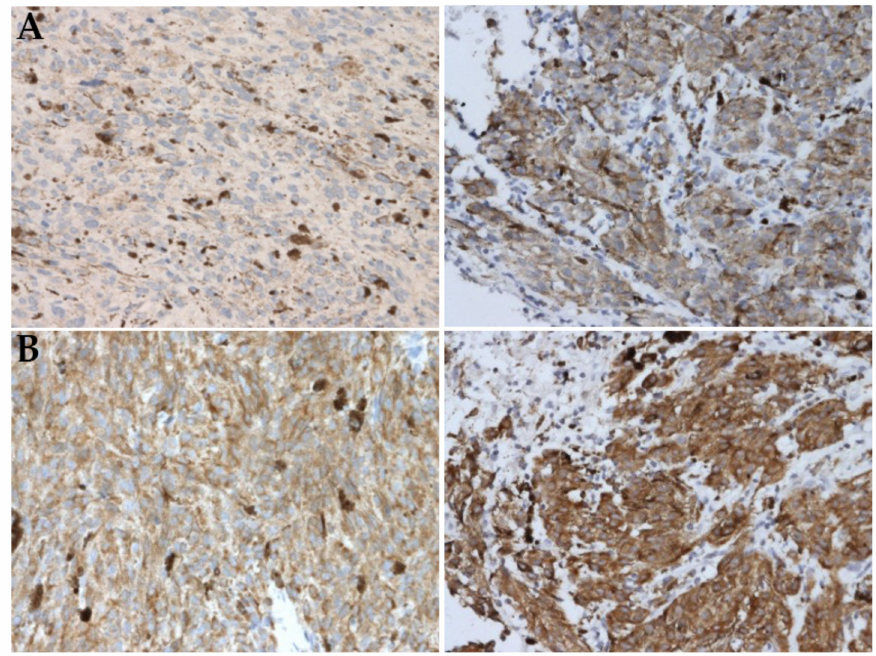
Figure 3. Immunohistochemical staining of KIT ( A ) and BCL2 ( B ) proteins in UM tumors. Nega- tive/weak expression is shown on the left and positive on the right. Immunoperoxidase, diaminoben- zidine, 200 × .